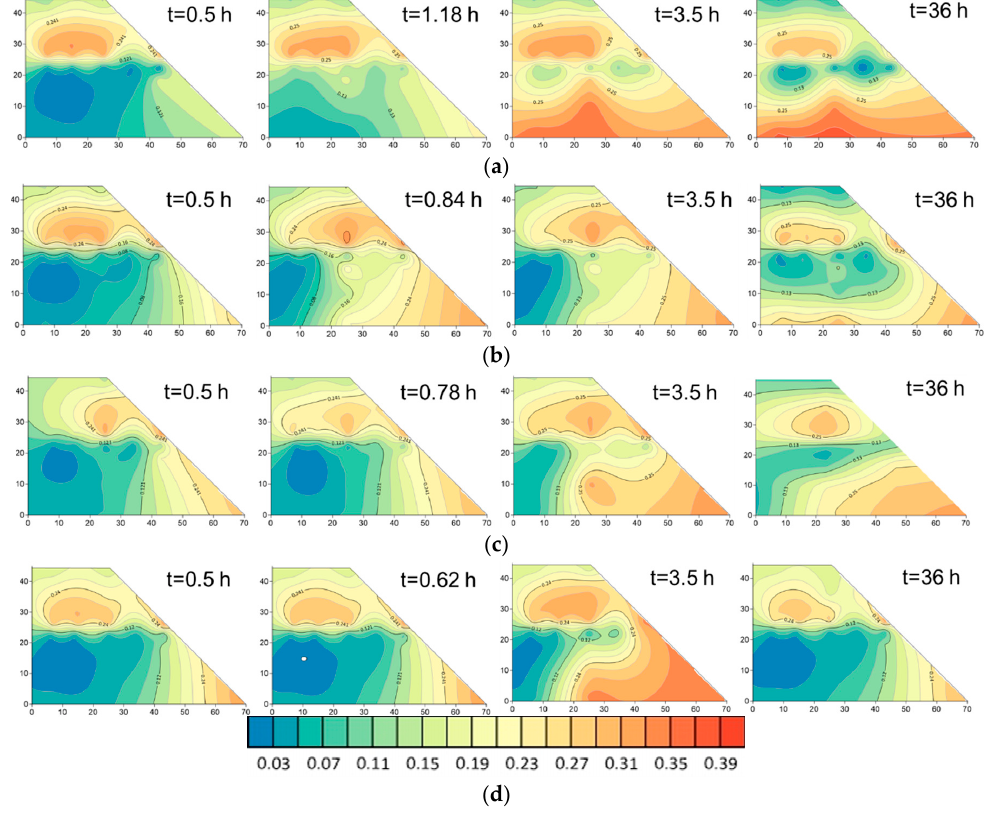
Figure 14. The VWC changes with elapsed time in case I, II, III, and IV (the VWC distribution after slope failure was verified by obtaining soil samples from various locations at the end of the test). ( a ) Case I. Multi-layer slope, 0 deg, 75 mm/h; ( b ) Case II. Multi-layer slope, 7 deg, 75 mm/h; ( c ) Case III. Multi-layer slope, 15 deg, 75 mm/h; ( d ) Case VII. Multi-layer slope, 21 deg, 75 mm/h.